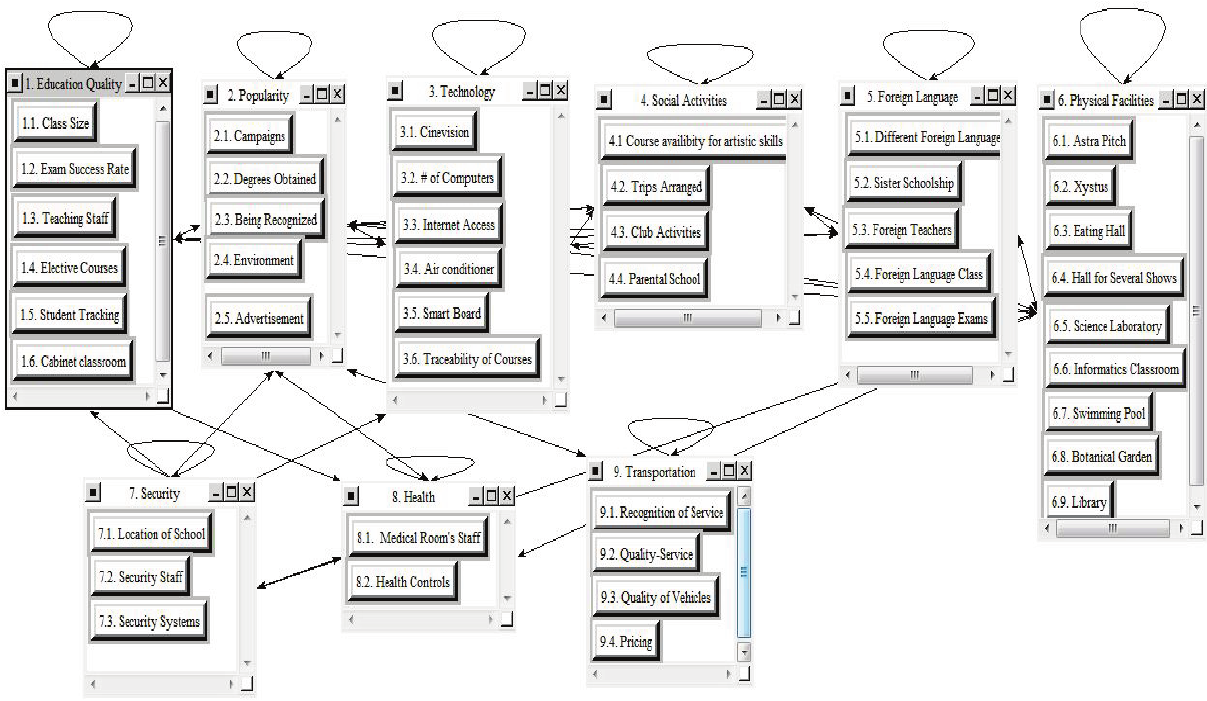
Fig. 1. Model view captured from SuperDecisions